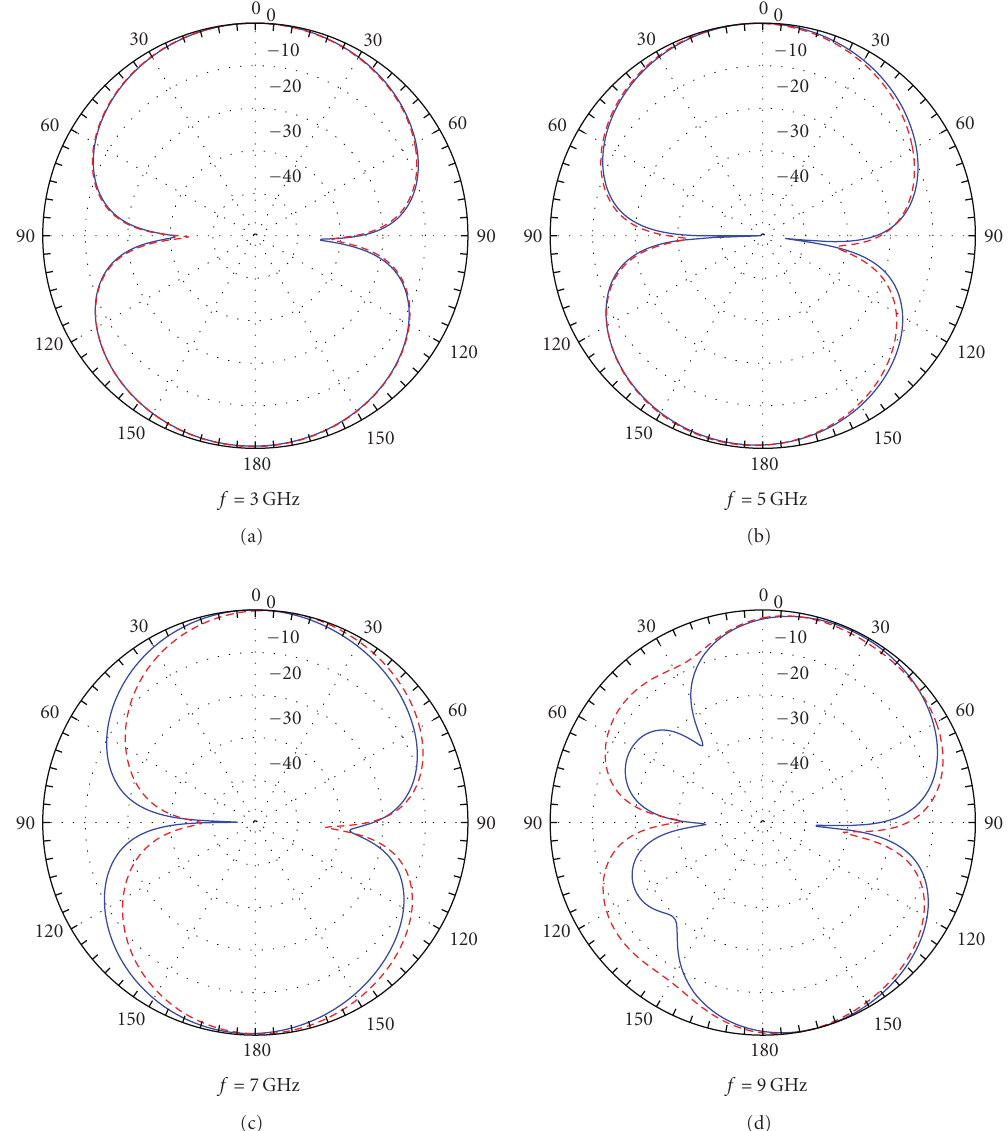
Figure 19: Simulated E -plane ( XZ -plane) radiation patterns for the four-element UWB array at element spacing d = 28mm (solid line) compared to a single antenna element (dashed